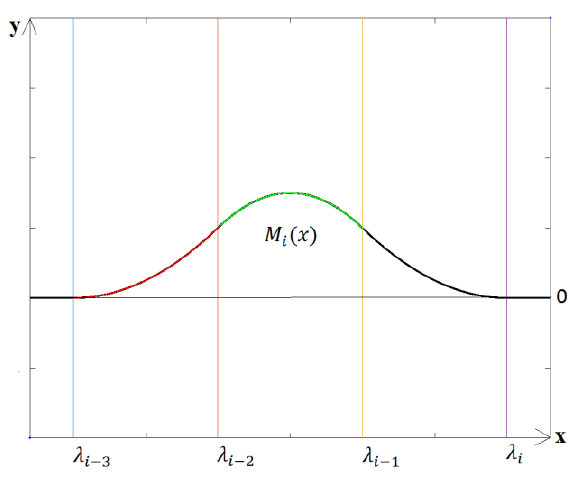
Figure 1. A typical B-spline with one variable, and stands for first and last knot,